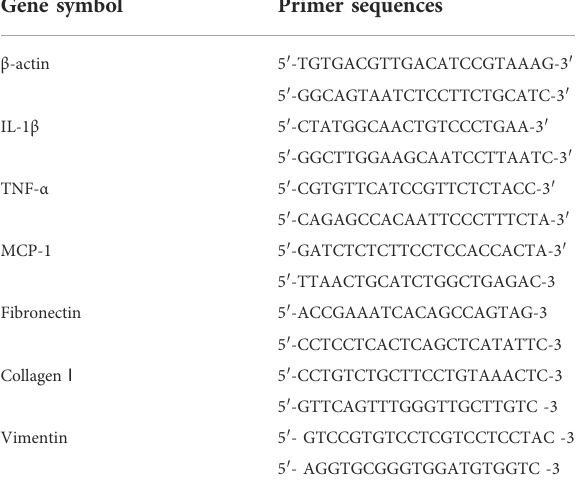
TABLE 1 Primer sequences for